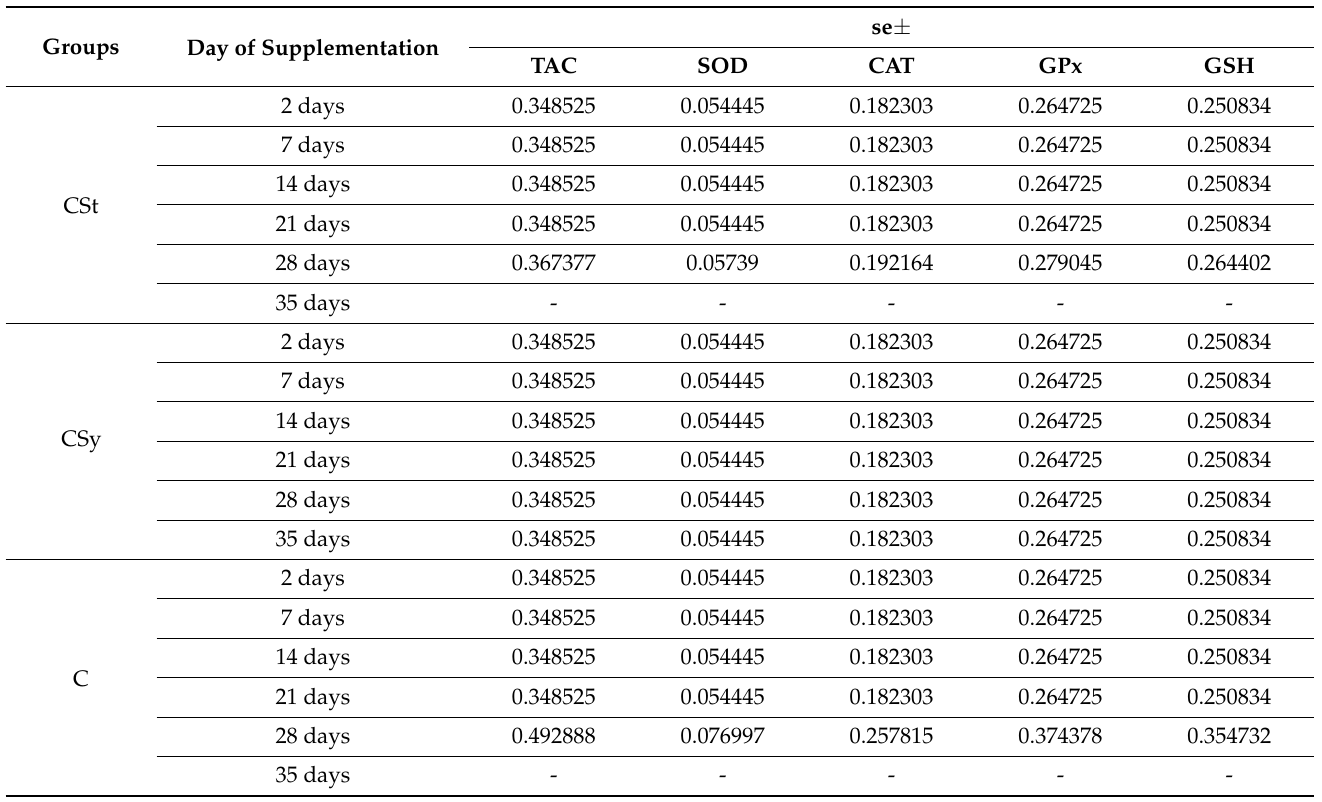
Figure 5. Activities of Glutathione (GSH) in the 2-, 7-, 14-, 21-, 28-, 35-day-old honey bees’ hemolymph after two methods of supplementation with hemp extract: C–control (pure sugar syrup), Csy–hemp extract in syrup, Cst–hemp extract on strips. (Two-Way ANOVA: supplementation method: F (2,146) = 56,662, p = 0.0000; days of supplementation: F (4,138) = 435,40, p = 0.0000; supplementation method × days of supplementation F (8,138) = 14,742, p = 0.0000. Table 1. Standard error for activities for antioxidant enzymes (for all groups from 2–35 days during the experiment) in hemolymph samples after two methods of supplementation with the hemp extract: C—control (pure sugar syrup), Csy—hemp extract in syr-up, Cst—hemp extract on strips, according to two-way